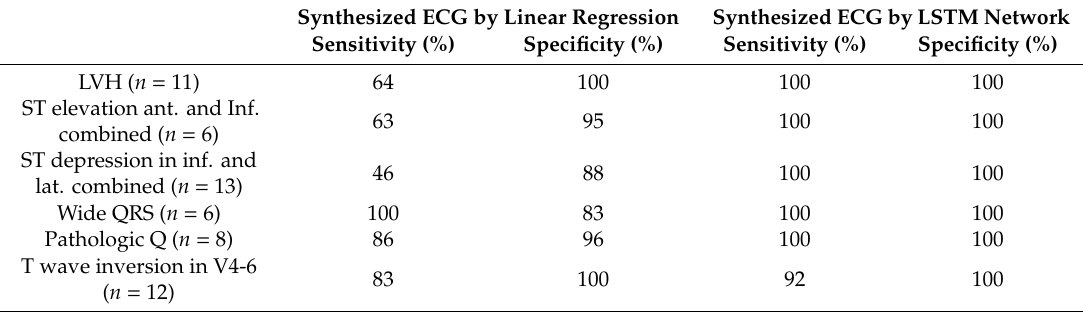
Table 3. Sensitivity and specificity of pathologic findings in the reconstructed ECGs. Synthesized ECG by Linear Regression Synthesized ECG by LSTM Network Sensitivity (%) Specificity